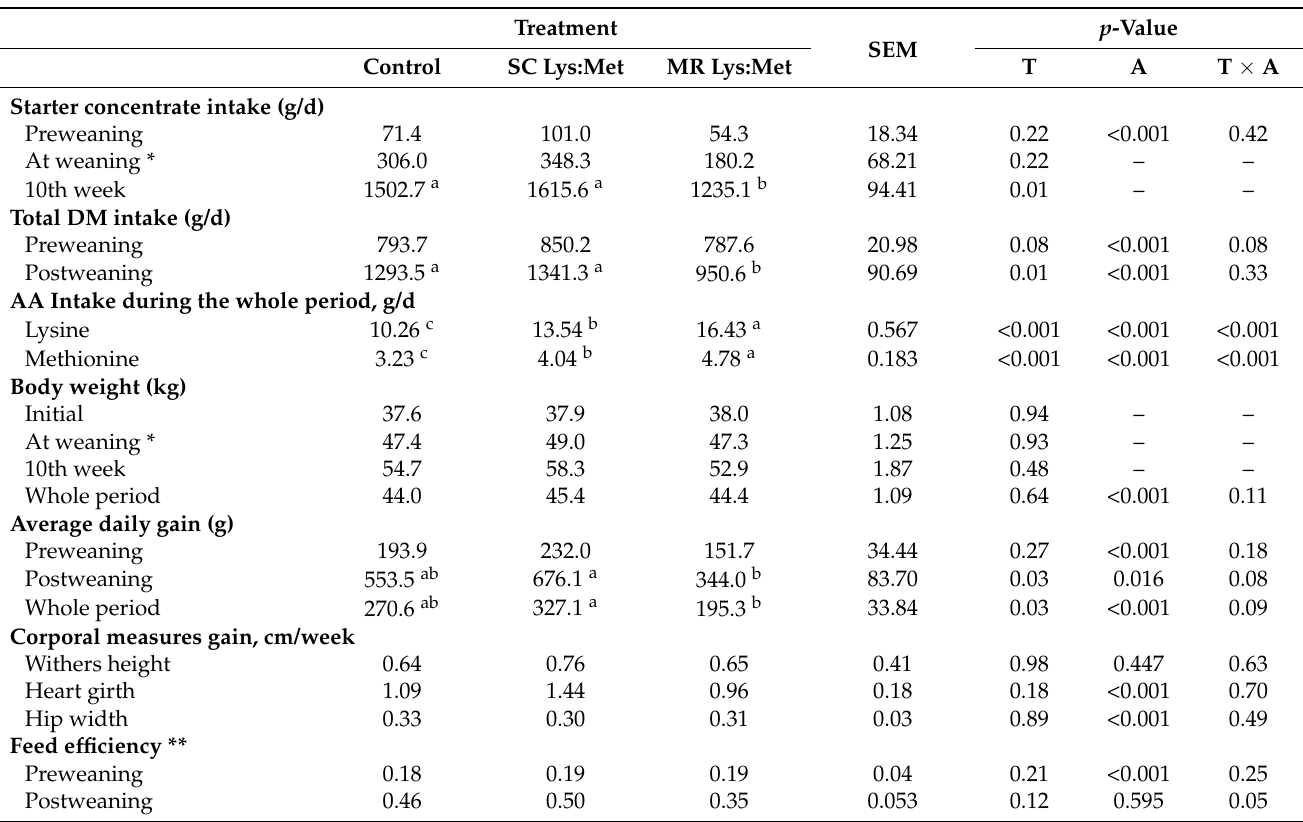
Table 2. Starter intake, total intake, and feed efficiency of dairy calves in the step-up/step-down feeding system with or without lysine and methionine supplementation in starter or milk